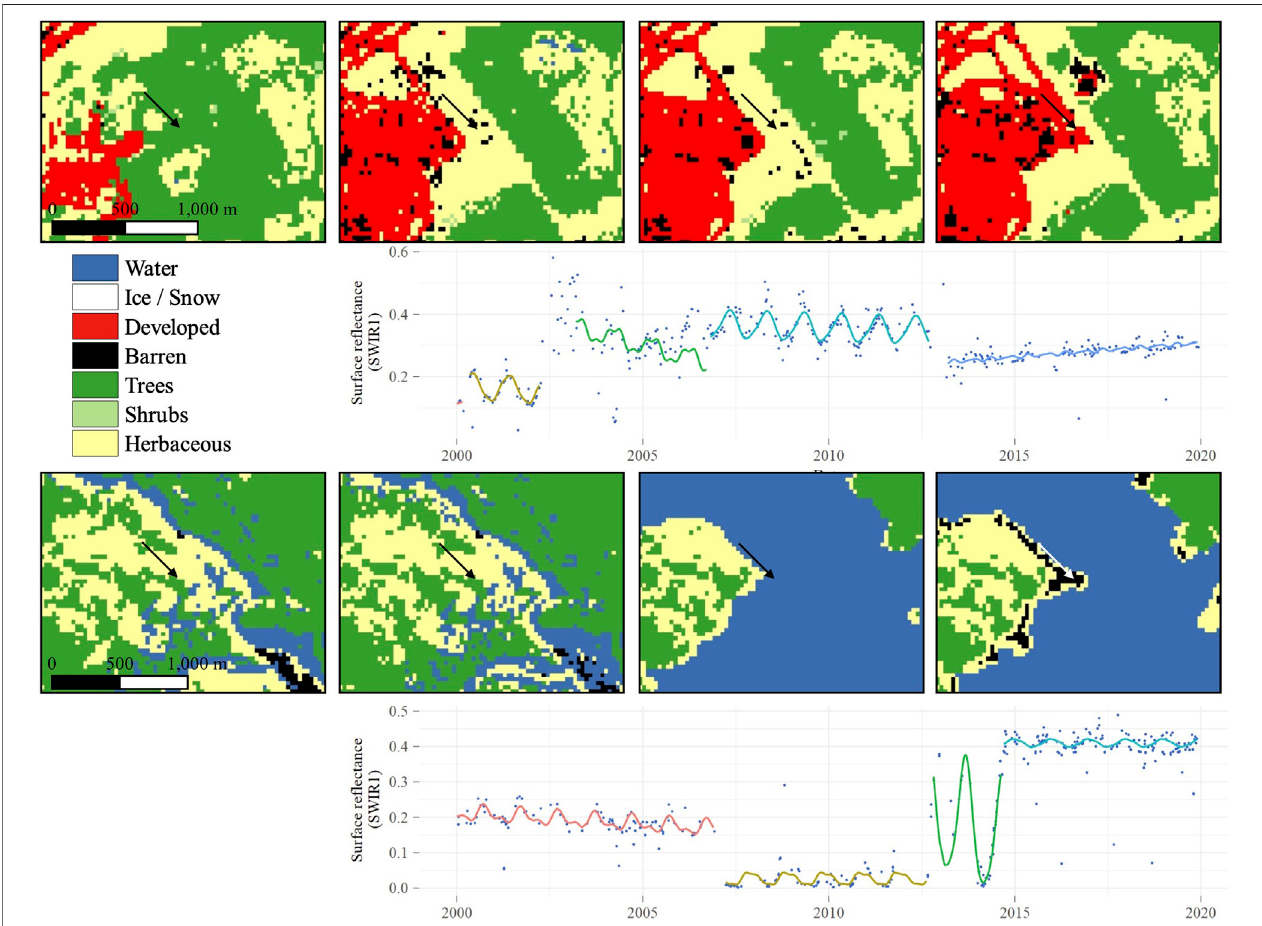
FIGURE 8 | Illustration of land cover and land cover change detection using CCDC. The top two rows show time series and changes in spectral re fl ectance associatedwithconstructionofanairportterminalinFortMeyers,Florida.Thebottomtworowsshowtimeseriesandchangesinspectralre fl ectanceassociatedwiththe fl oodingofadamandthesubsequentretreatinthewaterlevelinthestateofMinasGerais,Brazil.Theblackarrowsineachsetofimagesshowthelocationofthepixelfor which the SWIR1 re fl ectance time series are